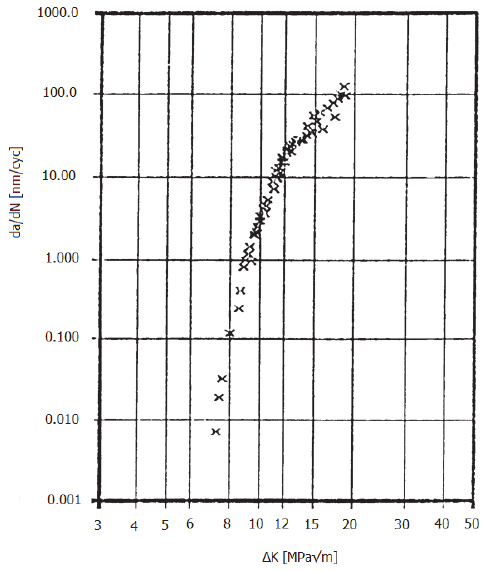
Figure 11: Curve da/dN – Δ